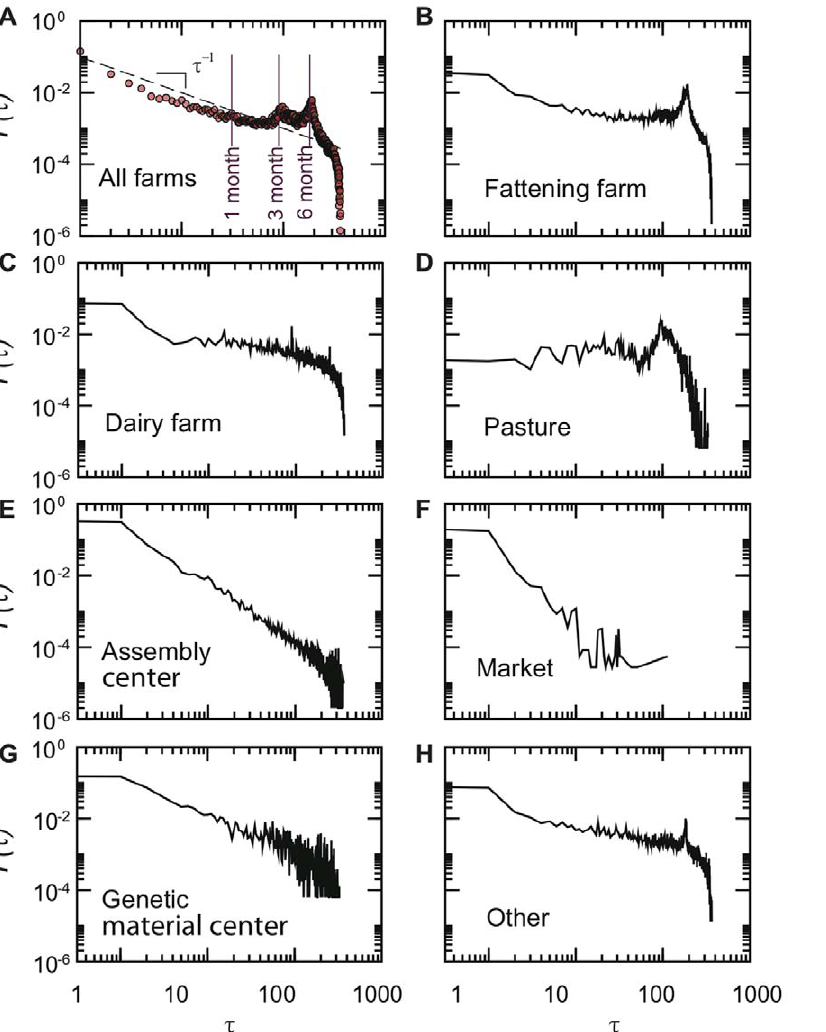
Figure 4. Probability distributions of the time interval t between two consecutive displacements of a bovine. t corresponds to the time during which the bovine stays at given premises. The seasonality behavior of breeding is clearly shown by the peaks at 3 and 6 months, while at shorter times the distribution behaves as t { 1 . The global distribution is a convolution of the time distributions obtained for different farm types, shown in panels B to H.